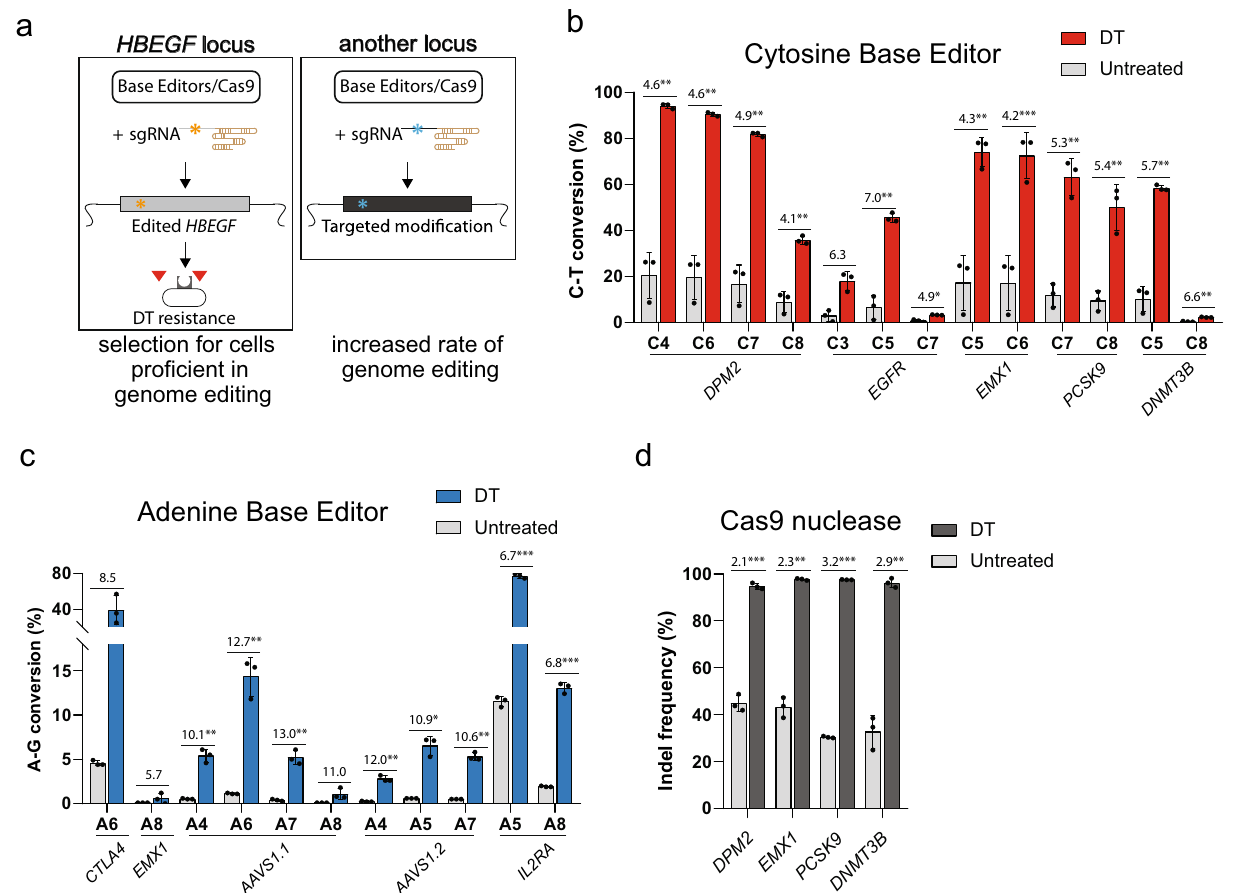
Fig. 2 Co-selection of base editing- and Cas9 nuclease-mediated genome modi fi cations. a Schematic of experimental design. b Bar graph of co-selected cytidine base editing events at the HBEGF locus and another locus, with or without DT selection, showing C – T conversion (%). c Bar graph of co-selected adenosine base editing events with or without DT selection, showing A – G conversion (%). d Bar graph of co-selected SpCas9-mediated genome editing events. In all graphs, the values and error bars re fl ect mean ± s.d. of n = 3 independent biological replicates. Relative fold changes between DT-selected and nonselected cells are indicated in the graphs. * P < 0.05, ** P < 0.01, *** P < 0.001, Student ’ s paired t test (two-tailed). P values are calculated as below: in b , DPM2 (C4 = 0.0070, C6 = 0.0063, C7 = 0.0061, and C8 = 0.0061), EGFR (C3 = 0.0506, C5 = 0.0053, and C7 = 0.0184), EMX1 (C5 = 0.0031 and C6 = 0.0004), PSCK9 (C7 = 0.0028 and C8 = 0.0092), and DPM2 (C5 = 0.0038 and C8 = 0.0088); in c , CTLA4 (A6 = 0.0691), EMX1 (A8 = 0.3119), AAVS1.1 (A4 = 0.0091, A6 = 0.0090, A7 = 0.0090, and A8 = 0.1044), AAVS1.2 (A4 = 0.0072, A5 = 0.0107, and A7 = 0.0027), and IL2RA (A5 = 0.0006 and A8 = 0.0009); in d , DPM2 (0.0005), EMX1 (0.0016), PCSK9 (0.0002), and DNMT3B (0.0085). Source data of Fig. 2b – d are provided as a Source data fi